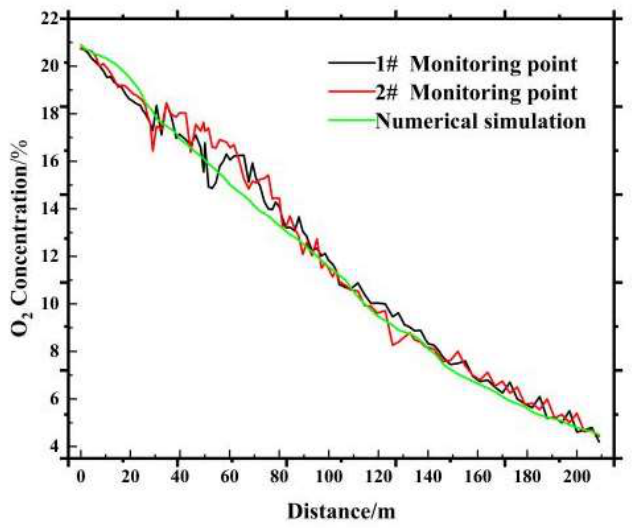
Figure 9. Beam tube monitoring data and numerical simulation prediction curve. The regression equation for the numerical simulation prediction curve based